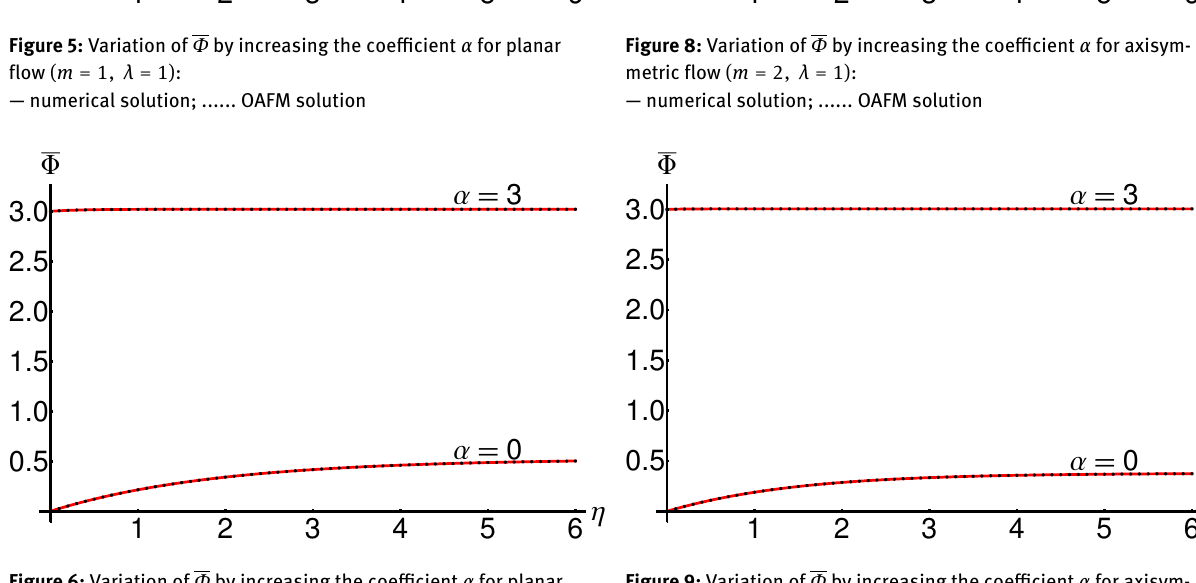
Figure 9: Variation of Φ by increasing the coeflcient α for axisym- metric flow ( m = 2, λ = 5) :